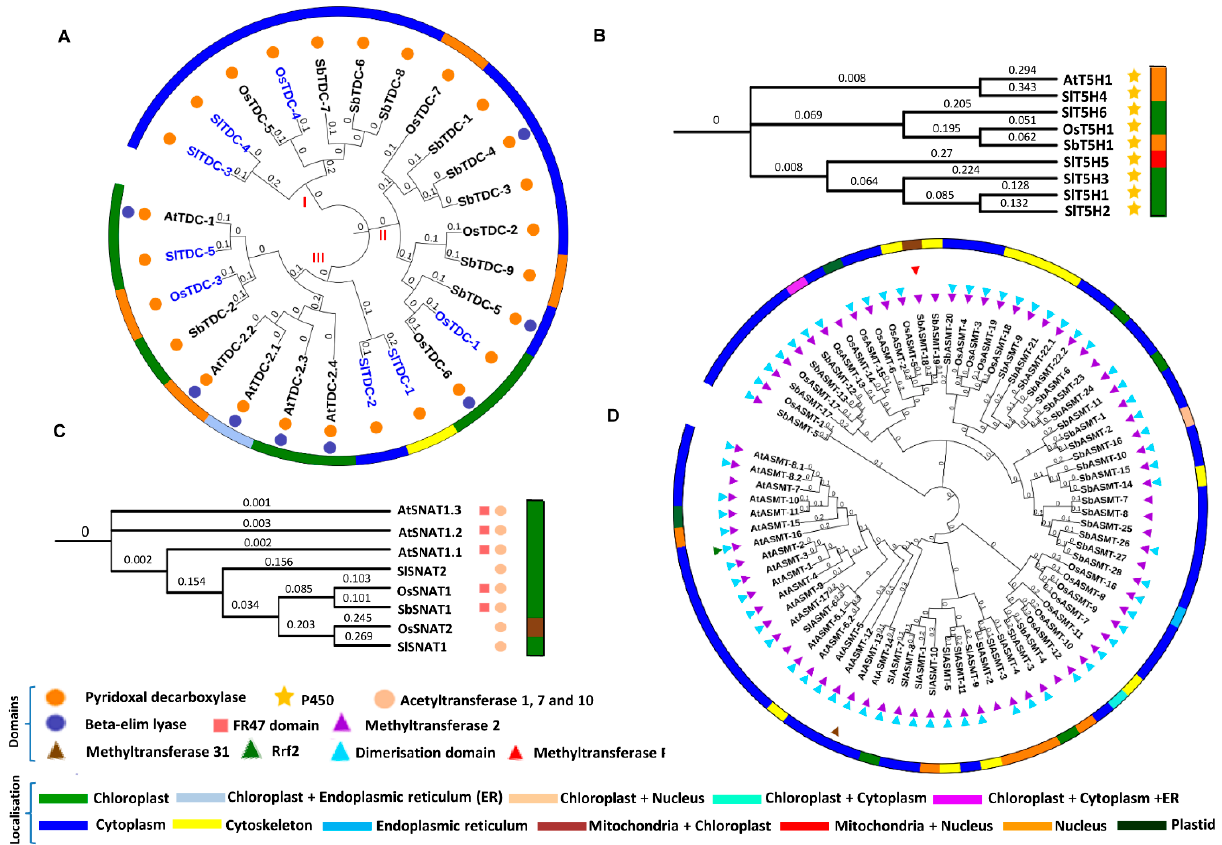
Figure 3. Evolutionary analysis, domain and localization details of genes encoding Ser and Mel biosynthetic enzymes. Phylogenetic tree depicting evolutionary relationship between genes encoding Ser biosynthetic enzymes, ( A ) tryptophan decarboxylase genes ( TDC) and ( B ) tryptophan 5-hydroxylase genes ( T5H ), and Mel biosynthetic enzymes ( C ) serotonin N-acetyltransferase genes ( SNAT) and ( D ) acetyl-serotonin methyltransferase genes ( ASMT) , from Arabidopsis, rice, sorghum and tomato. Localization details are indicated by the coloured strip besides the phylogenetic trees ( A – D ). The proteins labelled in blue have been previously characterized. The branch lengths indicate evolutionary time between the two nodes.